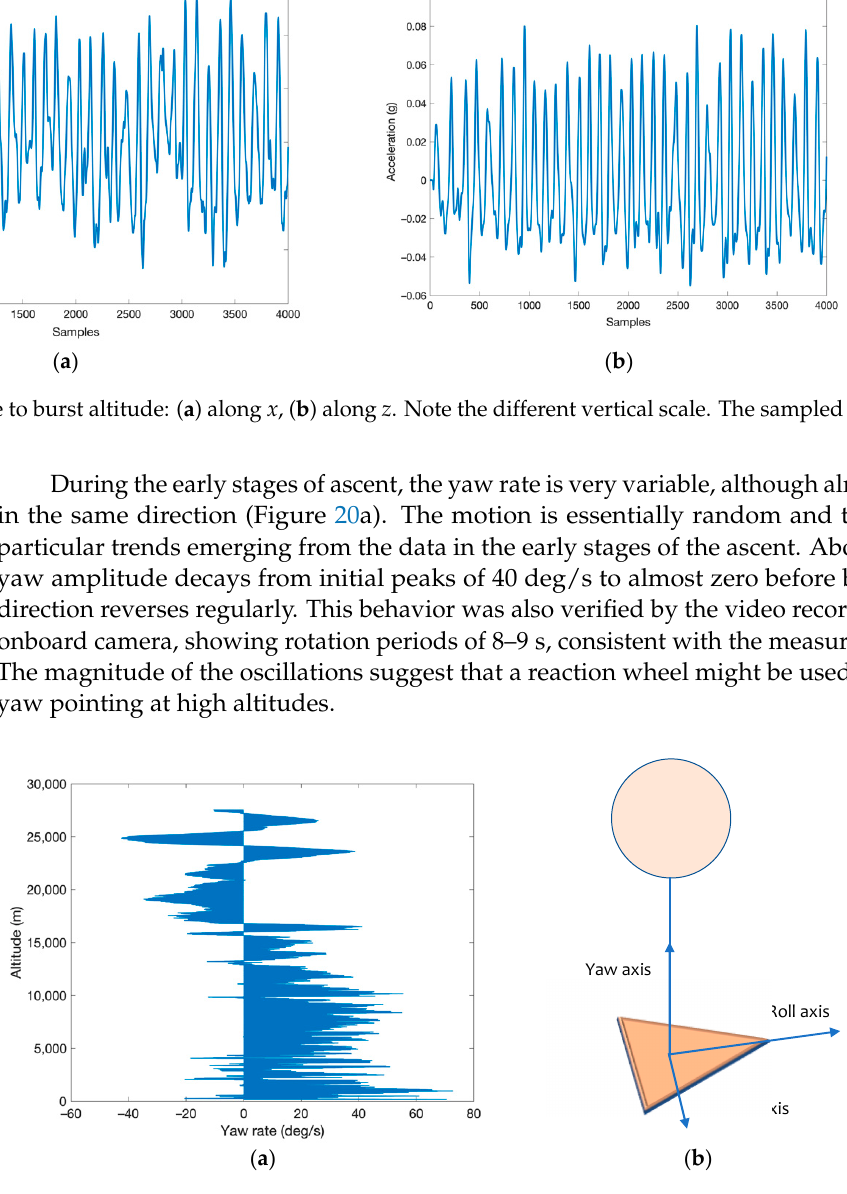
axis. As shown in Figure 21a, the ascent phase is characterized by small oscillations of amplitude decreasing with altitude. Figure 21b shows a detail of pitch oscillation close to burst altitude. At burst, the payload undergoes a series of upturns, and this was also con- firmed by the recorded videos. Contrary to ascent, the descent phase, which is dominated